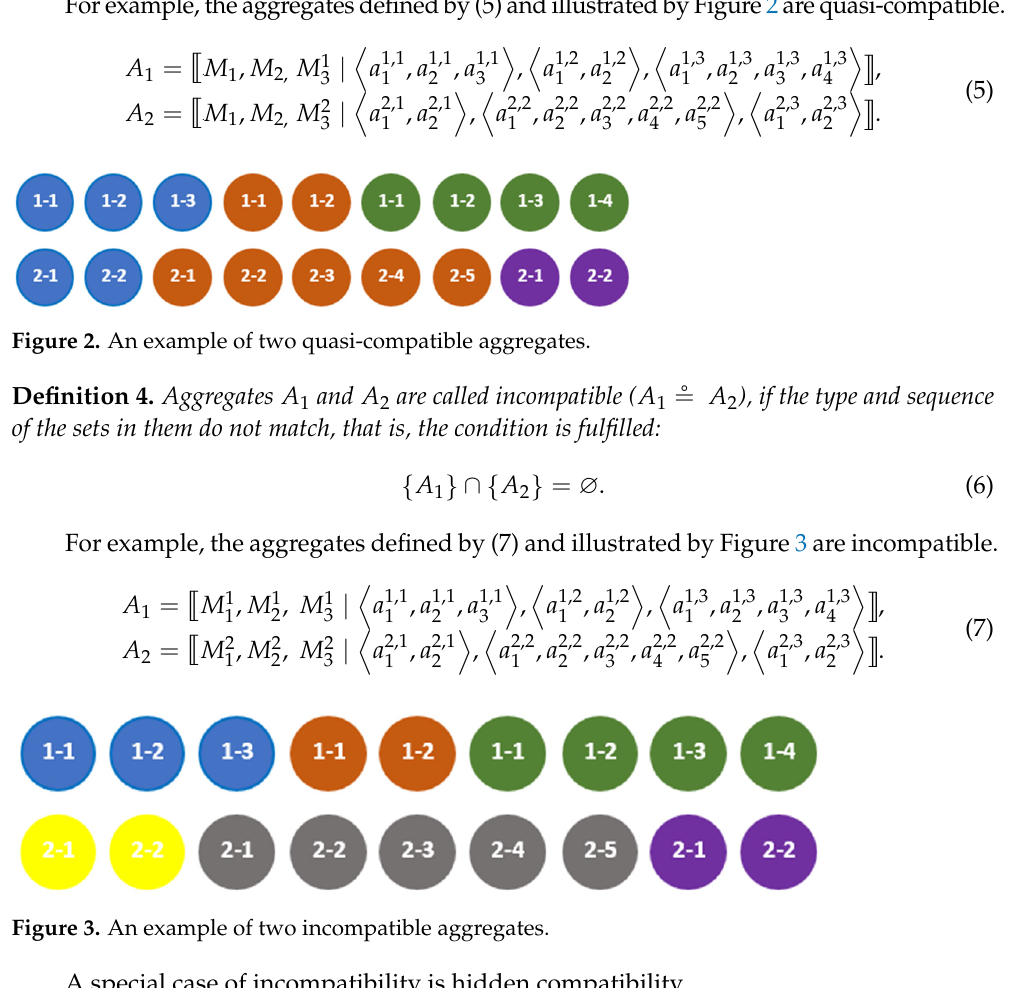
Figure 1. An example of two compatible aggregates. Figure 2. An example of two quasi-compatible aggregates. Definition 4. Aggregates 𝐴 (cid:2869) and 𝐴 (cid:2870) are called incompatible ( 𝐴 (cid:2869) ≗ 𝐴 (cid:2870) ), if the type and sequence of the sets in them do not match, that is, the condition is fulfilled: (cid:4668)𝐴 (cid:2869) (cid:4669) ∩ (cid:4668)𝐴 (cid:2870) (cid:4669) = ∅.